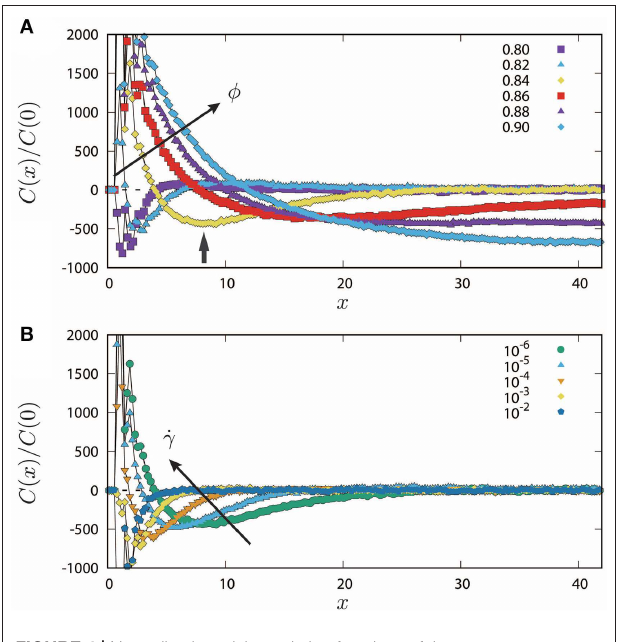
FIGURE 4 | Normalized spatial correlation functions of the transverse velocities C ( x ) / C (0), where symbols are as in Figure 2 . (A) The packing fraction φ increases as indicated by the arrow and listed in the legend, where ˙ γ = 10 − 6 t − 1 0 . The minimum of the data for φ = 0.84 is indicated by the short vertical arrow. (B) The shear rate ˙ γ increases as indicated by the arrow and listed in the legend, where φ = 0.84.